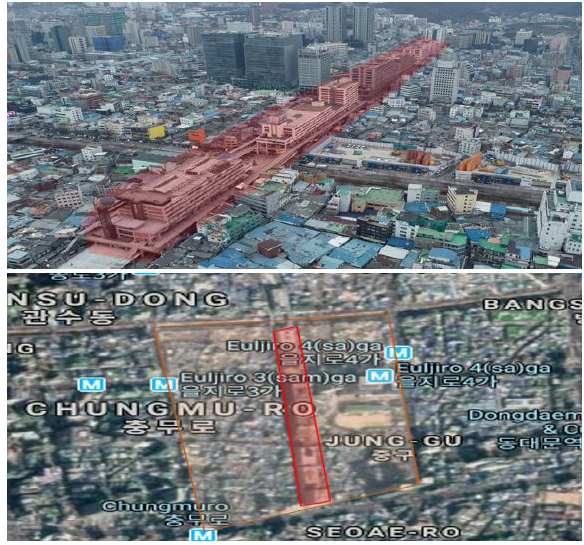
Figure 1. The Sewoon market building and its surroundings. the red square is Sewoon market building and the orange is its